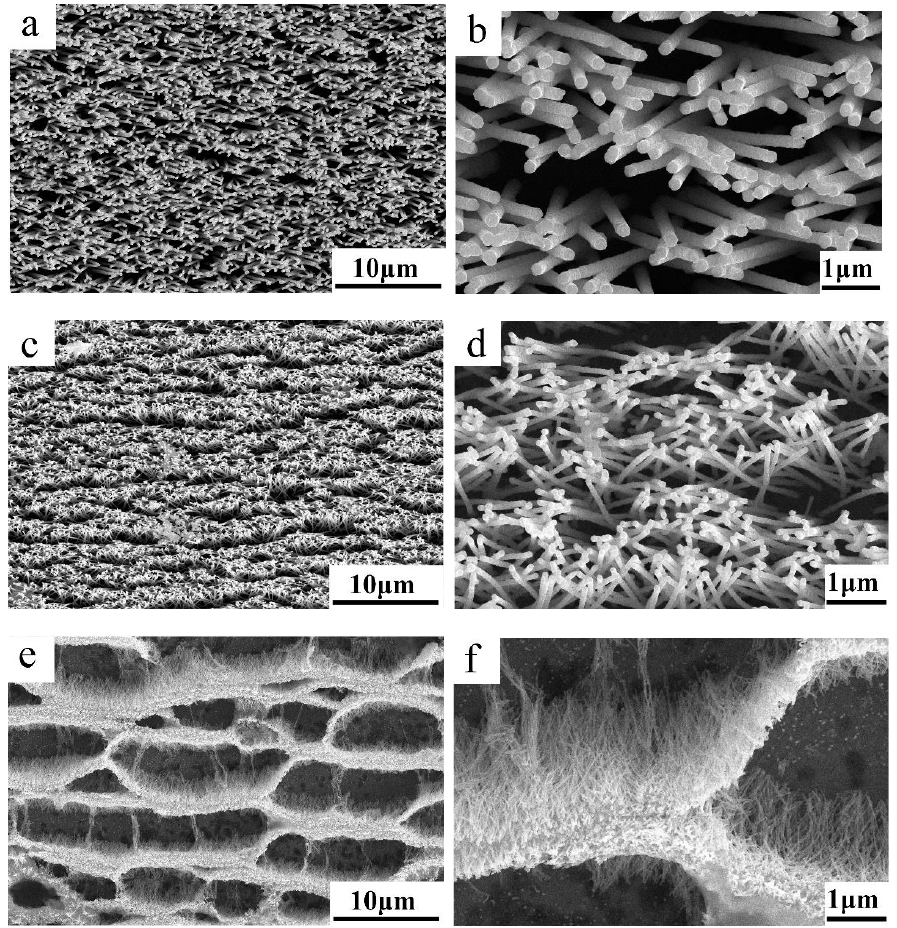
Figure 1. SEM images of the substrate surface with NWs of 200 ( a , b ), 100 ( c , d ), and 60 nm ( e , f ) diameter and 10 µm length.